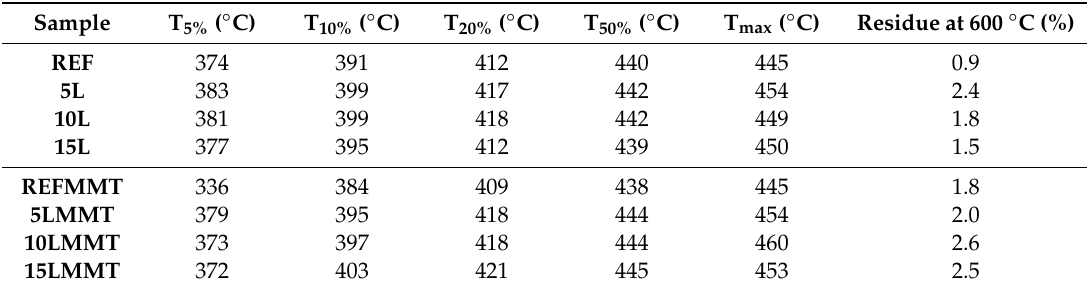
Table 1. Temperatures at which 5%, 10%, 20%, and 50% mass loss occurs for the PA6 and the PA6/MMT nanocomposites stabilized with triple layers.